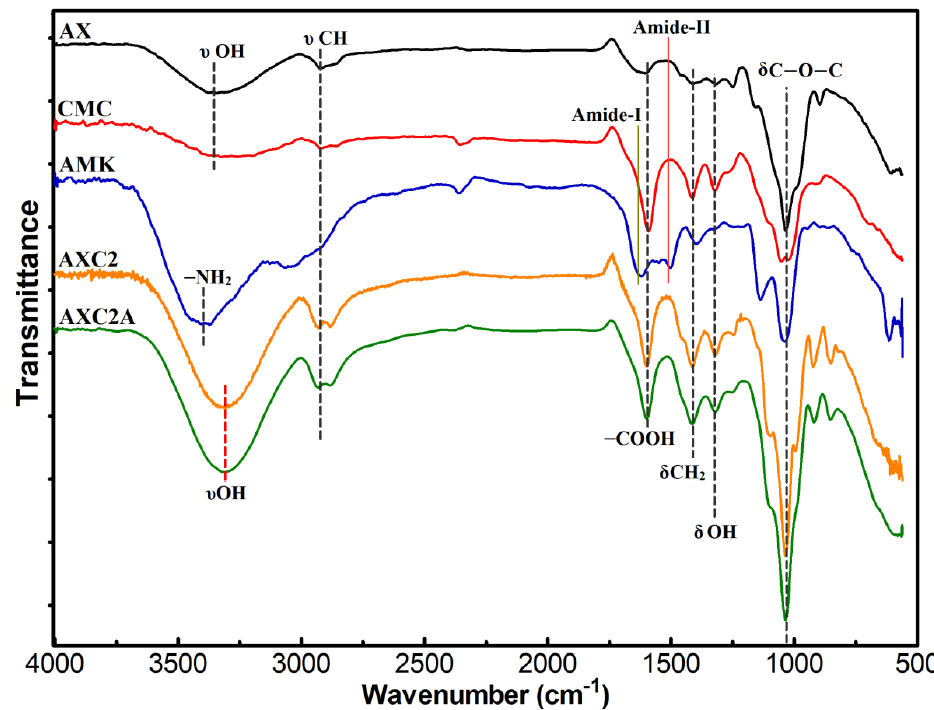
Figure 2. FTIR spectra of the AX, CMC, AMK, AXC2 (blank), and AXC2A (loaded) films.